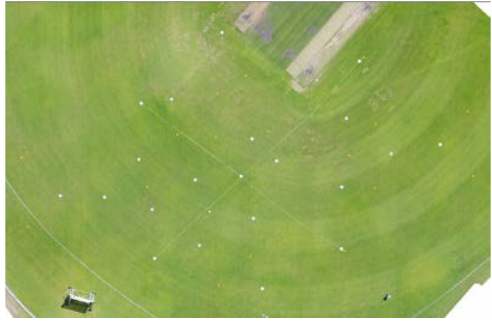
Figure 1 – Layout of geometric test field, cricket oval, University of Tasmania.